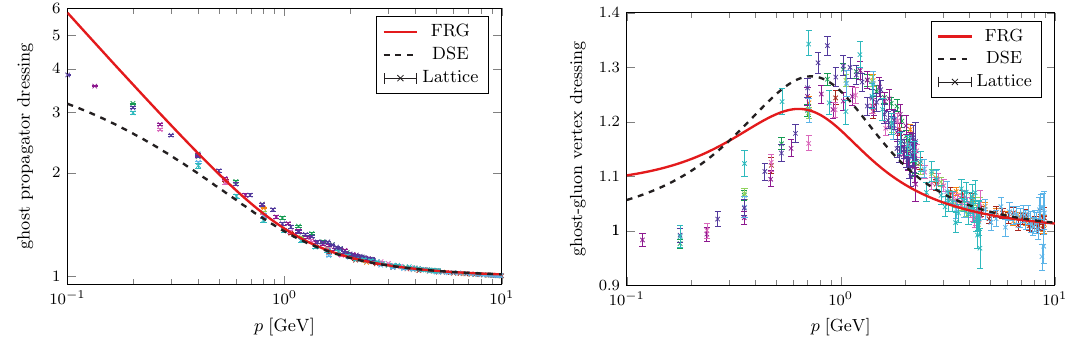
( p ) (left) and ghost-gluon vertex dressing c